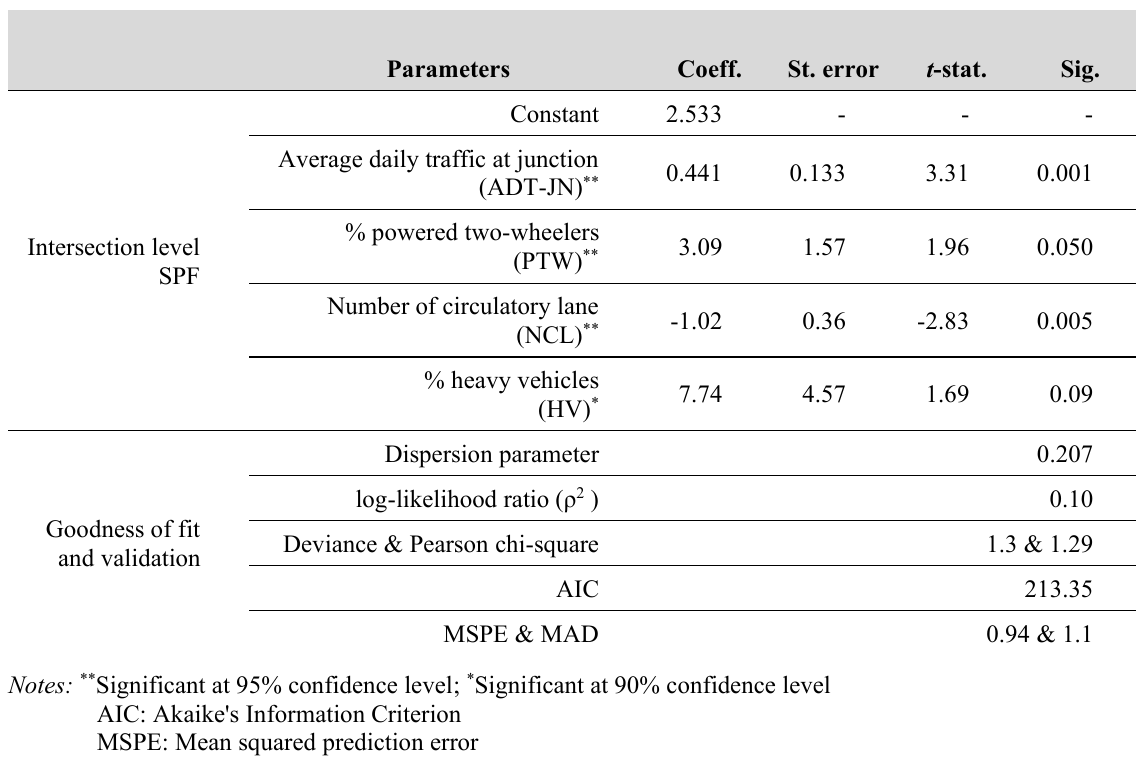
Table 3 Estimates of SPF model for intersection